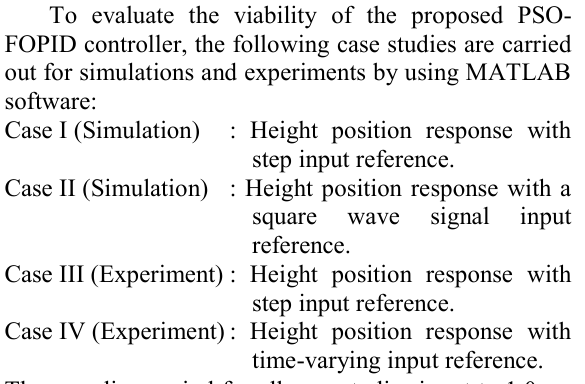
Figure 5. Configuration of the PSO-FOPID controller in a scissor mechanism platform